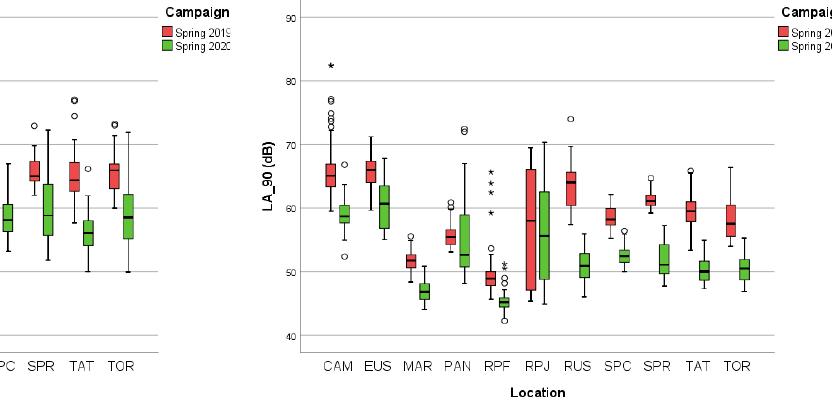
Figure 2: Sound levels distributions (10th percentile) at the 11 Lon- don locations (for Location IDs, see Table 1) before and during the lockdown measures implementation